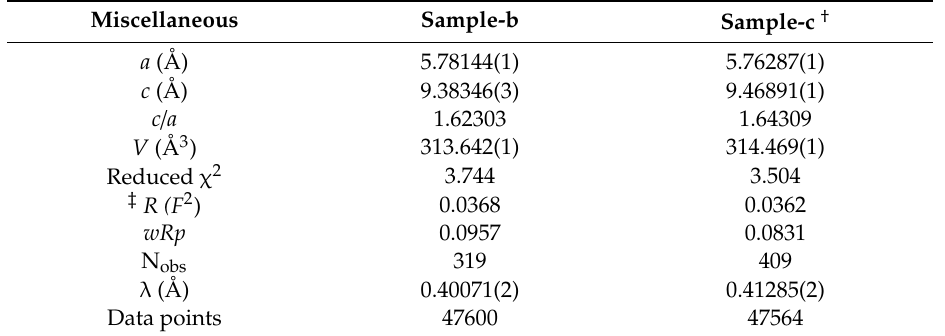
Table 4. HRPXRD data and Rietveld refinement statistical indicators for hausmannite samples-b and -c.